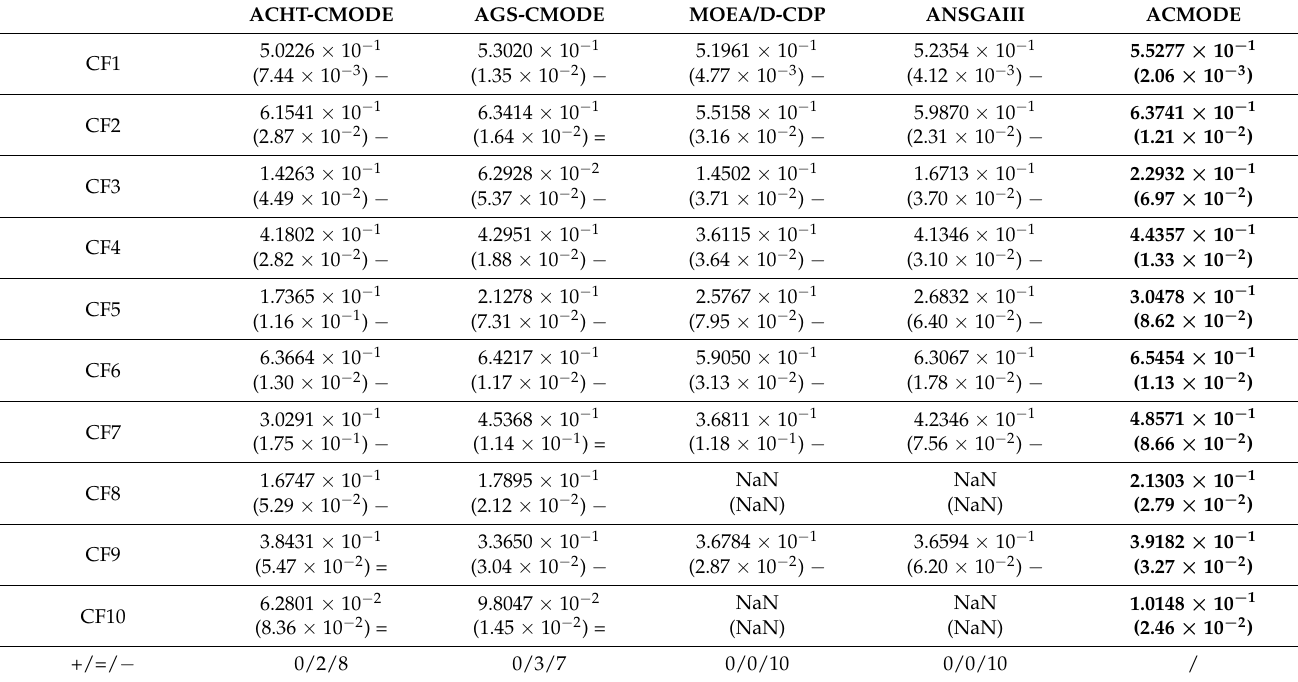
Table 3. HV results of all comparison algorithms on CF test